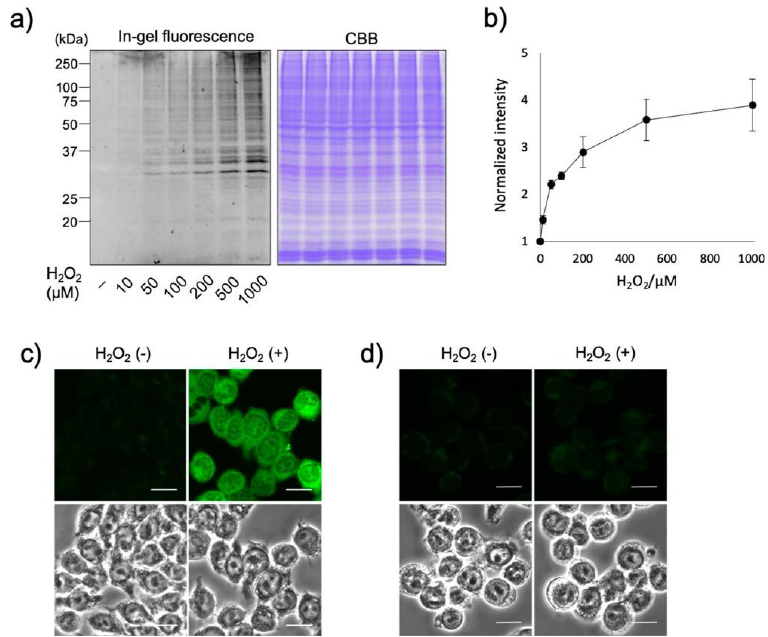
Figure 20. ( a ) SDS-PAGE analysis of Hyp-2-L (5 µM) labeling in living RAW264.7 cells with increasing H 2 O 2 concentrations. ( b ) Normalized fluroescence intensity gained from the former labeling. ( c ) Fixed cells after Hyp-2-L treatment. ( d ) Images obtained with HYDROP, a commercially available H 2 O 2 sensor, show low fluorescent on untreated cells. Reprinted with permission from